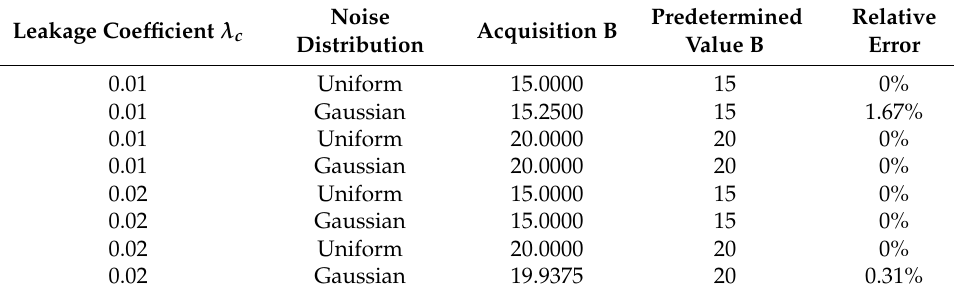
Table 3. The results of viscous damping coefficient under leakage.